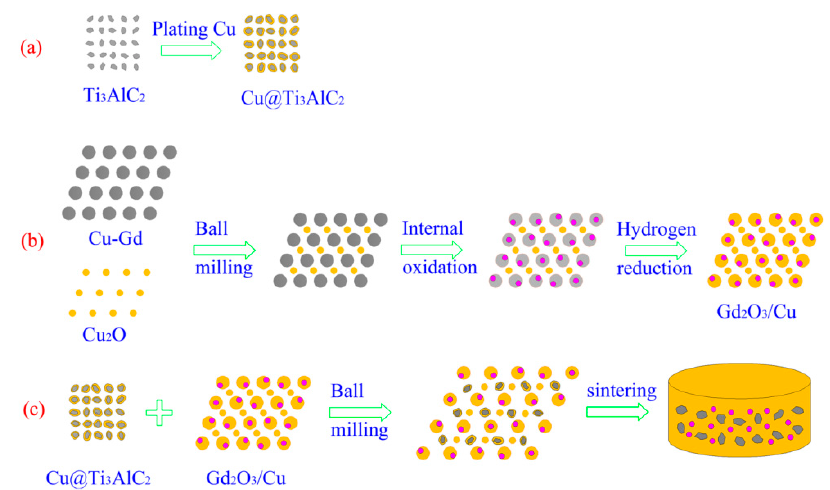
Figure 1. The preparation process diagram of the Cu@Ti 3 AlC 2 -Gd 2 O 3 /Cu composite: ( a ) electroless Cu plating on the surface of the Ti 3 AlC 2 particles, ( b ) in situ synthesis of Gd 2 O 3 reinforced phase, ( c )